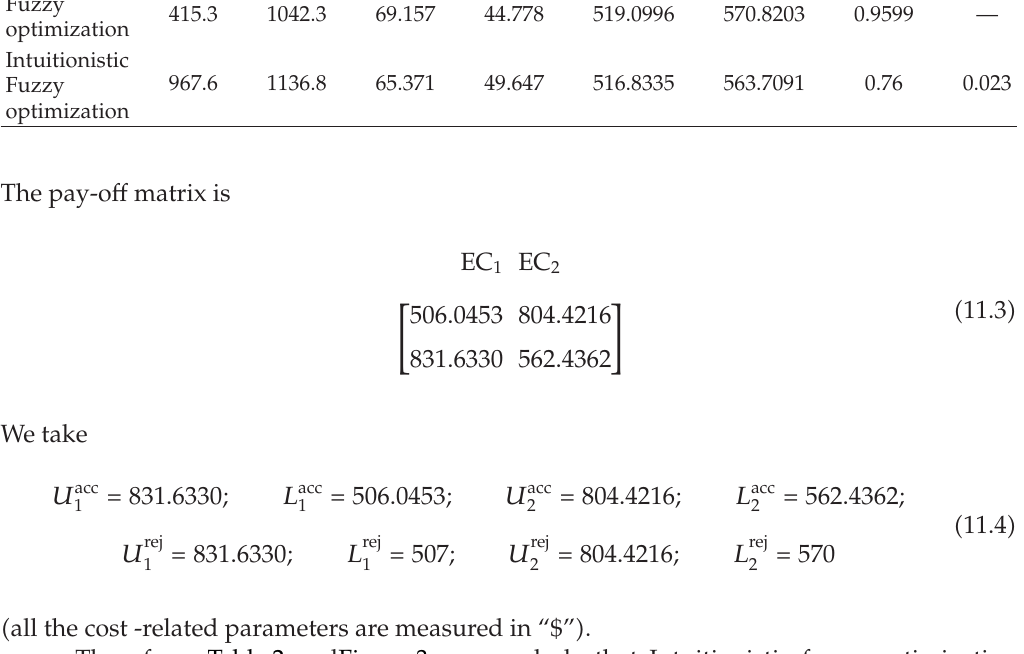
Table 2: Comparison of solutions of FO and IFO (cid:5) UNIFORM (cid:6) .